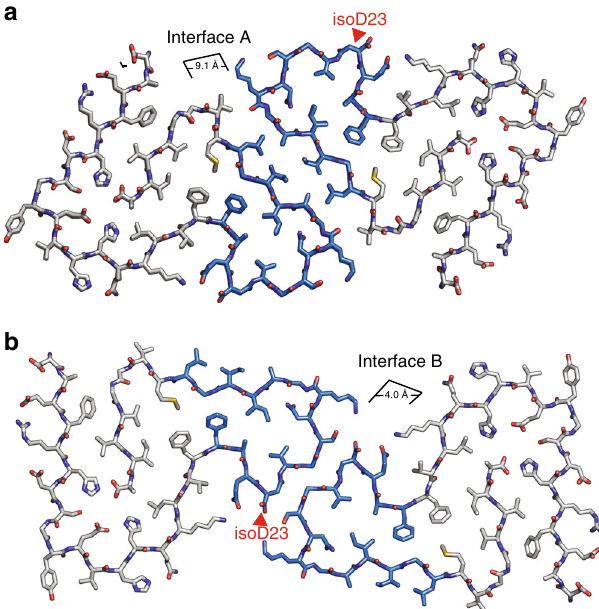
Fig. 5 Model of A β 20 – 34, isoAsp23 as the core of an A β 1 – 42 modi fi ed polymorph. a Model of A β 1 – 42, isoAsp23 centered on interface A. b Centered on interface B. Blue residues correspond to the crystal structure core (A β 20 – 34, isoAsp23 ), gray sticks correspond to the modeled extension (1 –